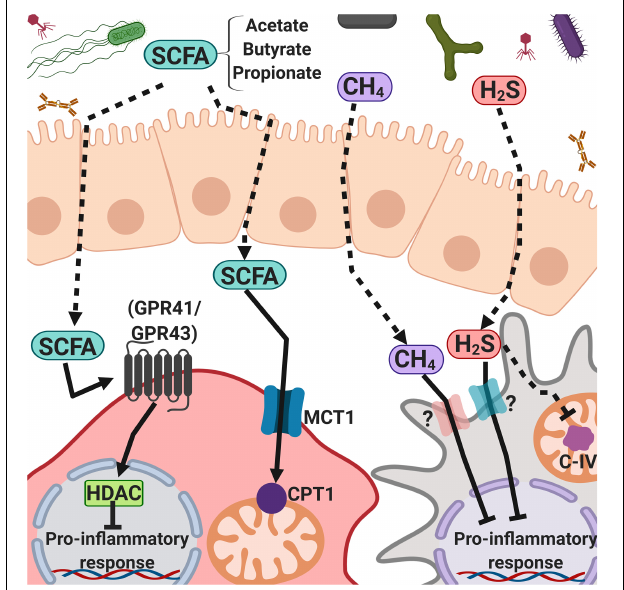
FIGURE 3 | Intestinal microbiota-derived short-chain fatty acids, methane, and hydrogen sulfide regulate inflammatory responses. Microbiota-derived products such as SFCAs (mainly acetate, butyrate, and propionate), CH 4 , and H 2 S can cross the intestinal epithelial cell barrier and interact with the immune system cells, activating G protein-coupled receptors or passing through cell membranes, promoting cell signaling and modulating the immune